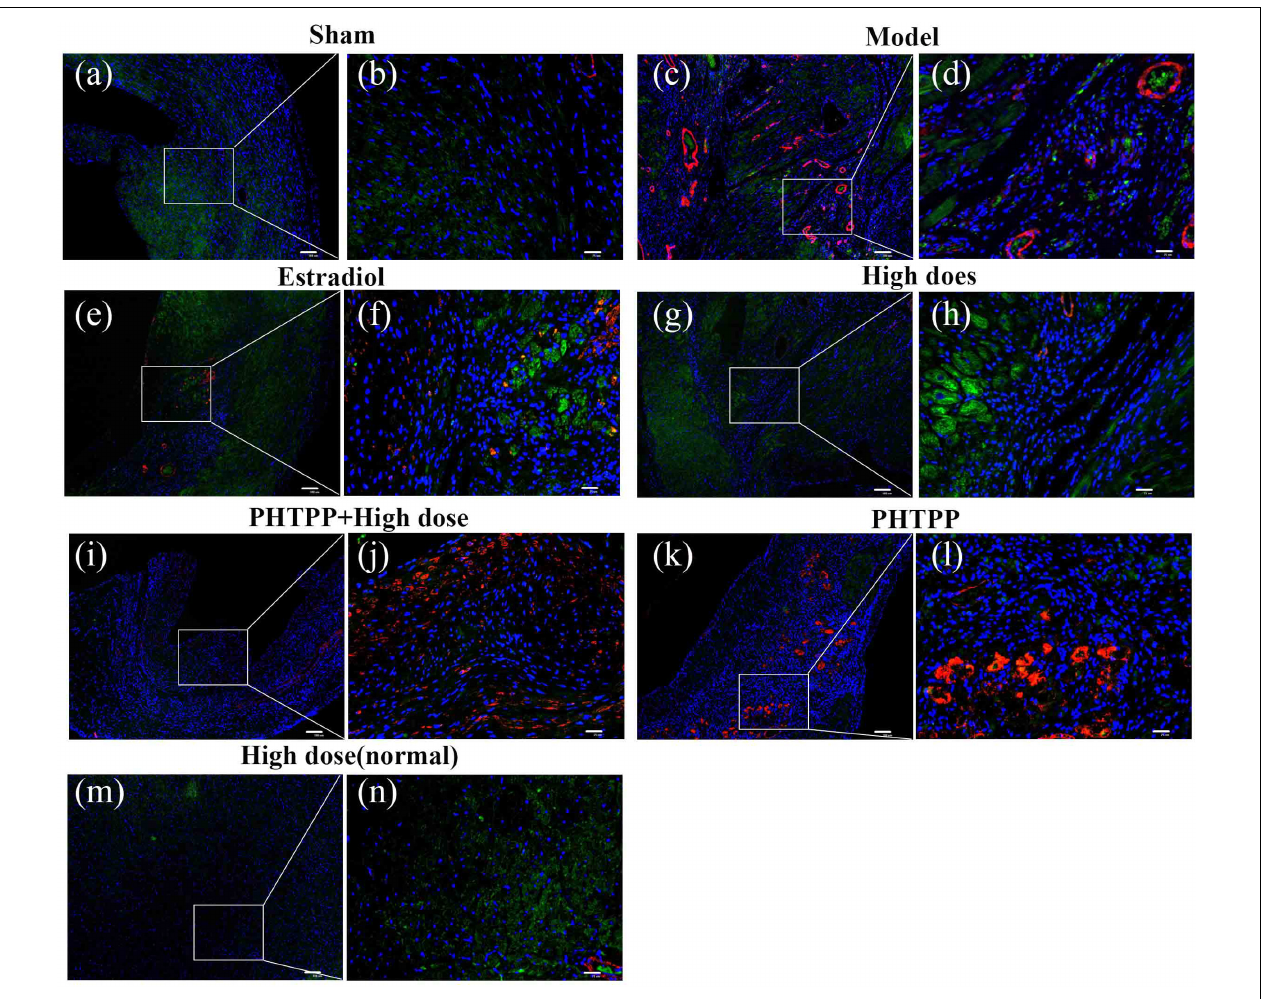
FIGURE 11 | Representative distribution images of ER β and α -SMA in rats treated with high-dose of GXDSF treated group and PHTPP. Immunofluorescence micrographs showing the differences in the distributions of ER β and α -SMA in the infarct and per-infarct region in all experimental groups (a,c,e,g,i,k,m) . Bars represents 100 µ m. The right part of the figures (b,d,f,h,j,l,n) were augmented at 4-fold in the corresponding (the left) part of figures. In addition, the different quasi-colors were depicted for distinguishing ER β and α -SMA, in which blue represented nuclei, green represented ER β and red represented α